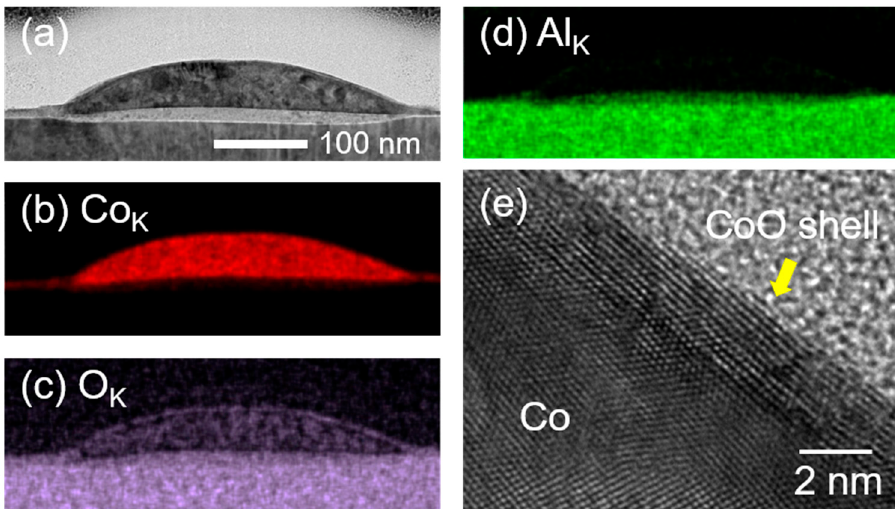
Figure 5. ( a ) TEM image of an individual NP in a 200-pulsed sample irradiated in air. The amorphous Al 2 O 3 interlayer is clearly observed. Corresponding EDX mapping images of Co K ( b ), O K ( c ), and Al K ( d ) emissions are illustrated. ( e ) High-resolution TEM image illustrating a CoO shell and Co crystal domains at the boundary of the NP. To estimate the wettability of NPs produced under atmospheric conditions, θ = 30.7